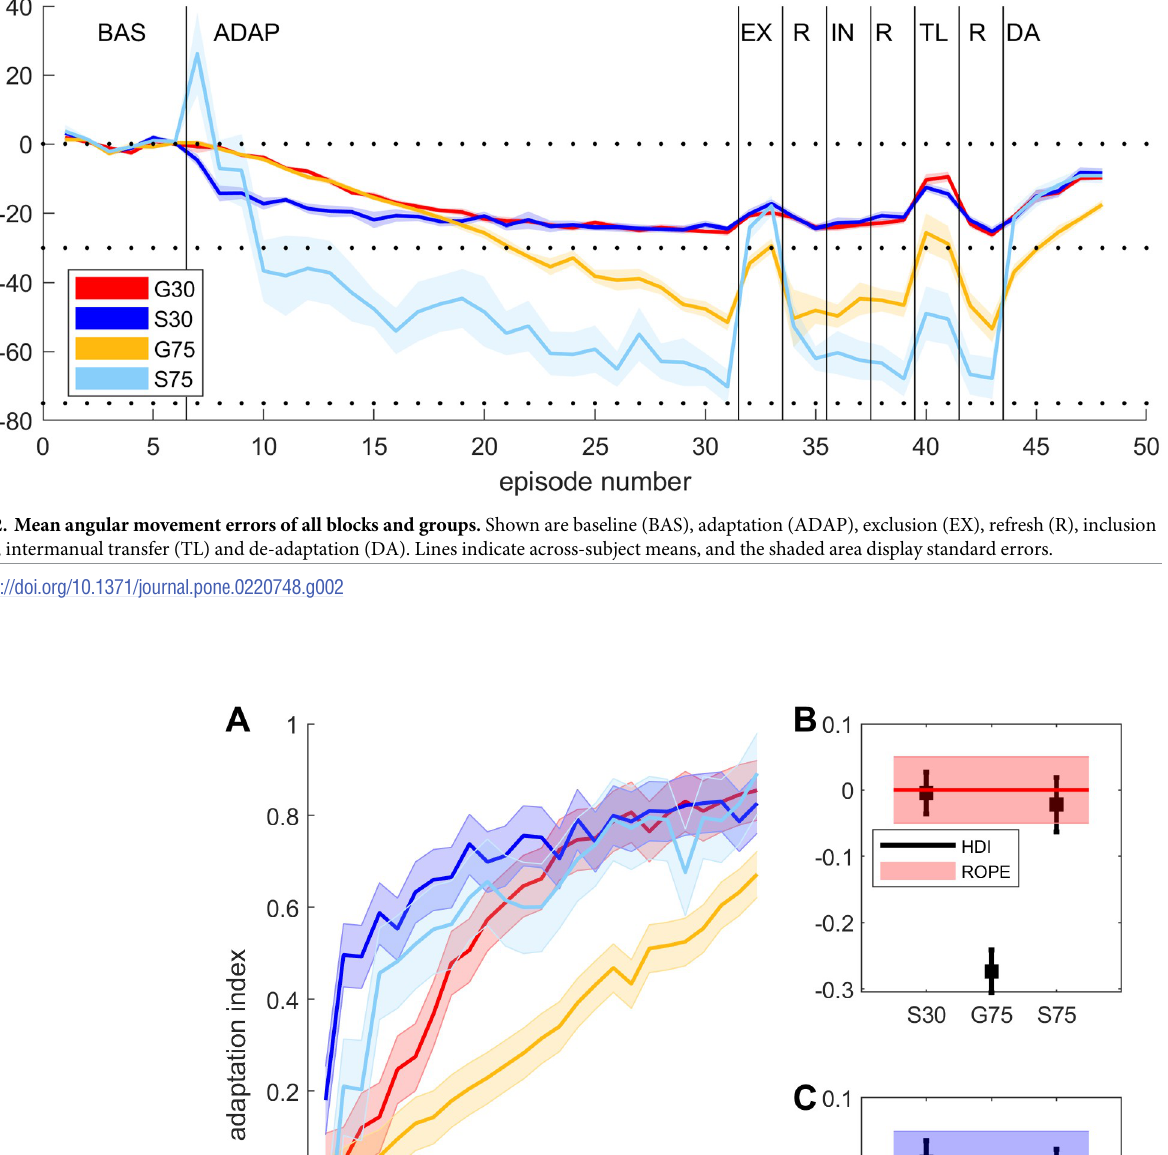
PLOS ONE | https://doi.org/10.1371/journal.pone.0220748 September 6,